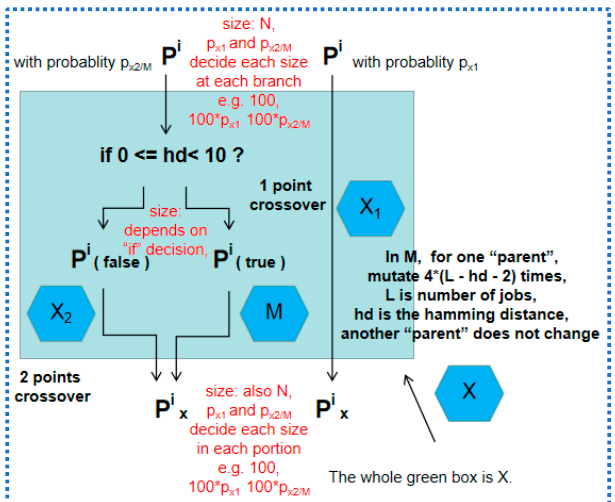
Figure 5. The details of the crossover operator X [5] for an evolutionary search is presented above (the asterisk in the figure is a multiplication sign “×”). The mutation operator M may help us to overcome the problem of premature convergence. M depends on the number of jobs. We use both one point crossover and two points